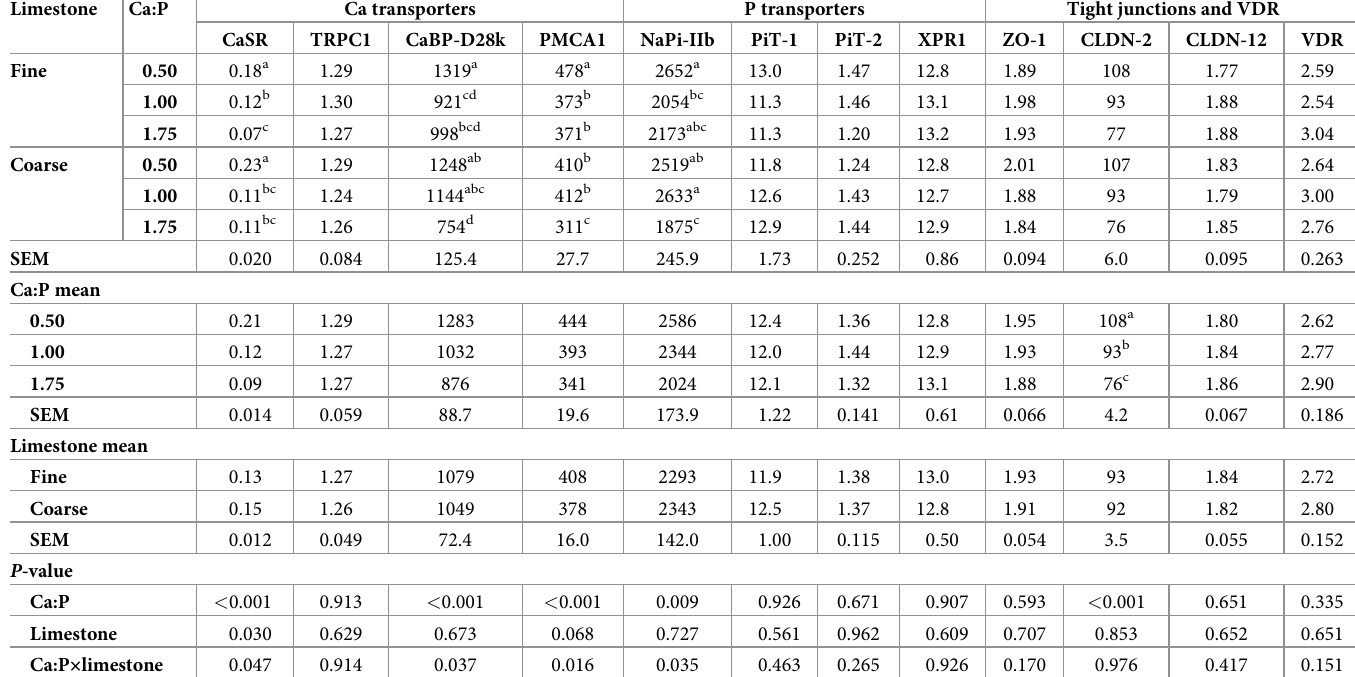
Table 2. Least square mean of mRNA expression levels of Ca and P transporters and claudins in the duodenal mucosa in broilers as affected by dietary total Ca: Total P ratio (Ca:P), limestone particle sizes and their interaction 1,2,3 . Limestone